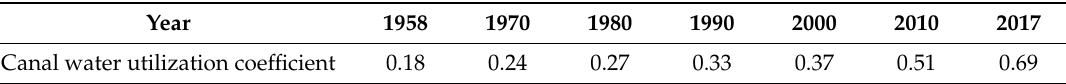
Table 2. Development of canal water utilization coefficient in Changma Irrigation District.